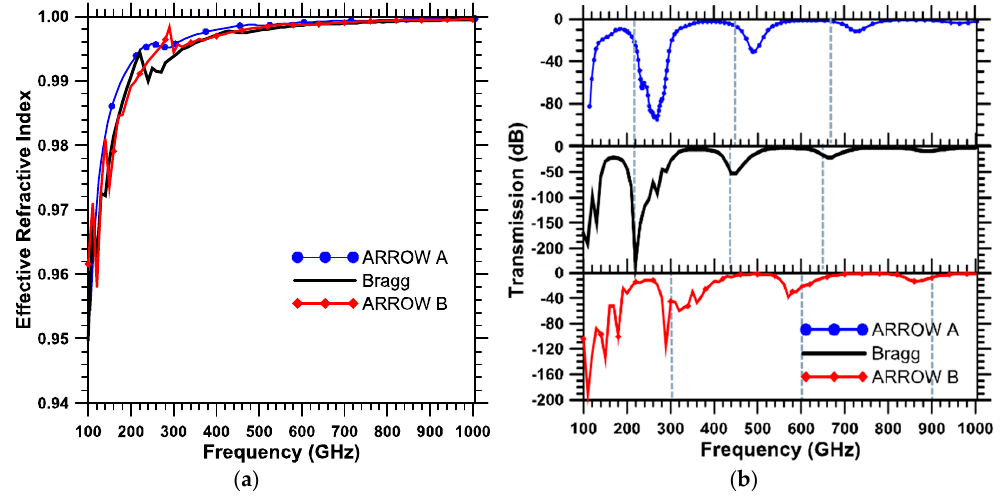
Figure 2. ( a ) Effective refractive index of ARROW A, ARROW B, and Bragg fiber; ( b ) Spectral transmission with high losses dips due to the resonant effect. The numerical simulations considered 1 m long fibers to the transmission analyses.